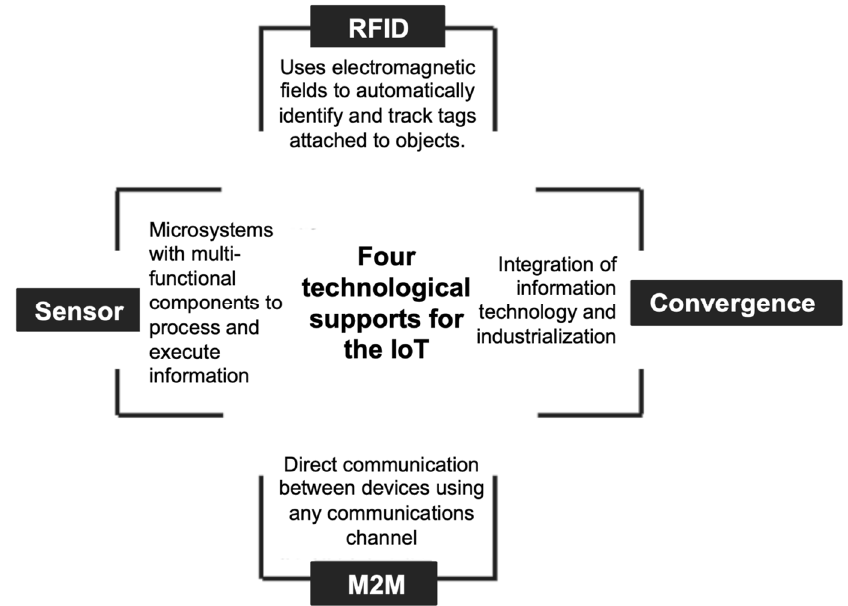
Figure 2. Technical support for the Internet of Things.